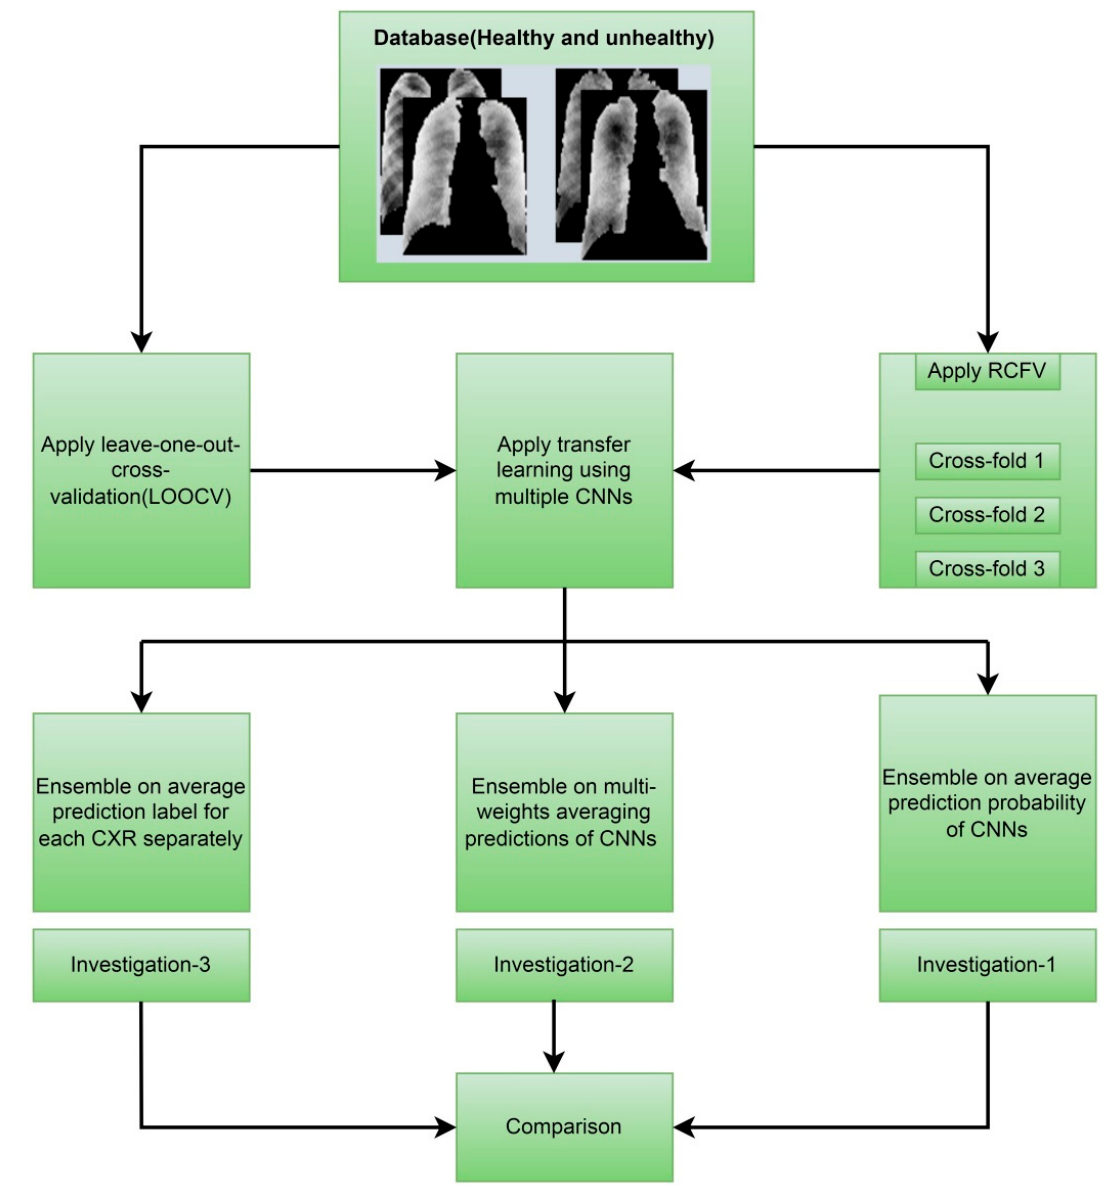
Figure 1. Summary of proposed methodologies in the study of ensemble investigations .